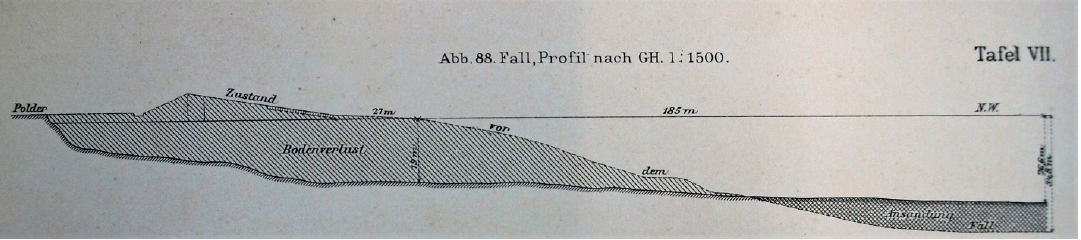
( a ) ( b ) Figure 7. ( a ) Map of 1881 flow slide (Uferfall) at Oud Noord-Beveland Polder, Zeeland. Original figure of Müller, W. Ernst Verlag, Berlin, 1898 [14]. For cross section G-H, see Figure 6. ( b ) Present day image of 1881 flow slide site with remains of dikes and a salt marsh, now called the Oesterput. Photo Google Earth, 2018. In Figure 6 and Figure 7a the original diagrams of Müller [14] are shown. Figure 7b shows the reconstructed location of this event on a 2018 Google Earth image. As can be seen in Figure 7 the shape of the northern coastline of Noord-Beveland today still shows the remains of lost dikes. The dikes were never repaired and the former polders (‘inlagen’) have been permanently lost, leaving here a wetland with salt marshes, today called the Oesterput. The encroachment of the Eastern Scheldt now has been arrested by the completion of the Delta works in 1987. Terzaghi cites a geological report, which may have stated that the event took place with ‘ catastrophic speed ’ and was announced by a ‘ muffled, thunder like roar’ . The description in Müller may have given Terzaghi the impression of a rapid landslide event like a rock- or mud avalanche (‘Bergsturz’ or ‘Erdrutschung’ in German), common in mountainous landscapes. The short time and high speed reported by Terzaghi for this flow slide event however was definitely not reported in the original eyewitness descriptions. In the English version of his handbook ‘Soil Mechanics in Engineering Practice’ [17], Terzaghi writes: ‘ Slides can occur only in loose saturated sands. They are caused by spontaneous liquefaction. The disturbance required to release a sand slide can be produced either by a shock or by a rapid change in the position of the water table. Once the movement has started, the sand flows as if it were a liquid and does not stop until the slope angle becomes smaller than 10° (about 1:6). The sand slides along the coast of the island of Zeeland in Holland belong in this category. The coast is located on a thick stratum of fine quartz sand that consists of rounded grains. The slope of the beach is only 15° (about 1:4). Yet, once every